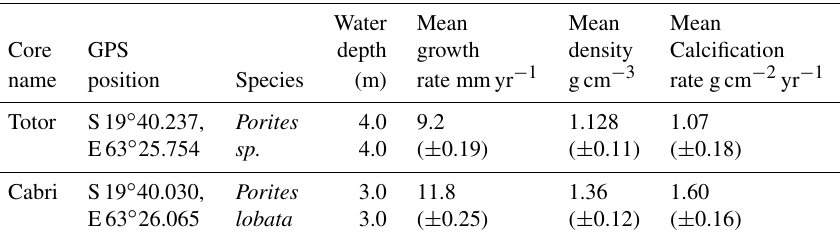
Table 1. Coral cores with their GPS co-ordinates and colony depths at low tide, with mean rates of extension, density and calcification over the complete length of the individual records (1907 to 2006 for Cabri; 1781 to 2005 for